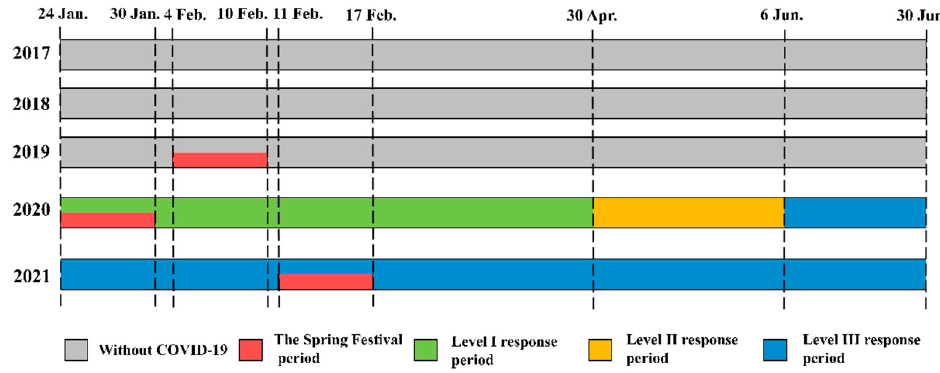
Figure 2. Visualization of the three different periods during COVID-19 analyzed in this study .